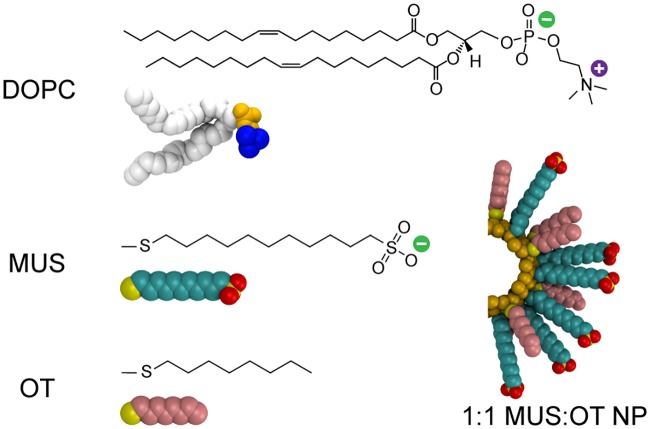
Simulation snapshots and corresponding chemical structures of the system components.The bilayer is composed of the lipid DOPC, which has two hydrophobic tails (white) and a zwitterionic head group (choline in blue, phosphate in yellow). Two ligands, MUS and OT, are grafted to a gold NP core in a 1:1 ratio. MUS has a hydrophobic backbone (cyan) and anionic sulfonate end group (yellow/red), while OT is purely hydrophobic (pink). Both ligands terminate in sulfur atoms bonded to the gold surface (yellow).